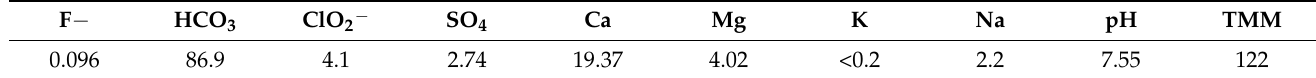
Table 1. Water-analysis values (mg/L) utilized in the